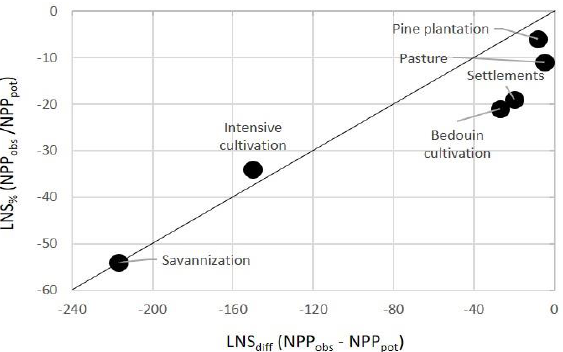
Figure 6. Observed NPP (NPP obs ) and potential NPP (NPP pot ) for the six LU types, in gC m -2 yr -1 . The line passes through equal values of NPP obs and NPP pot .